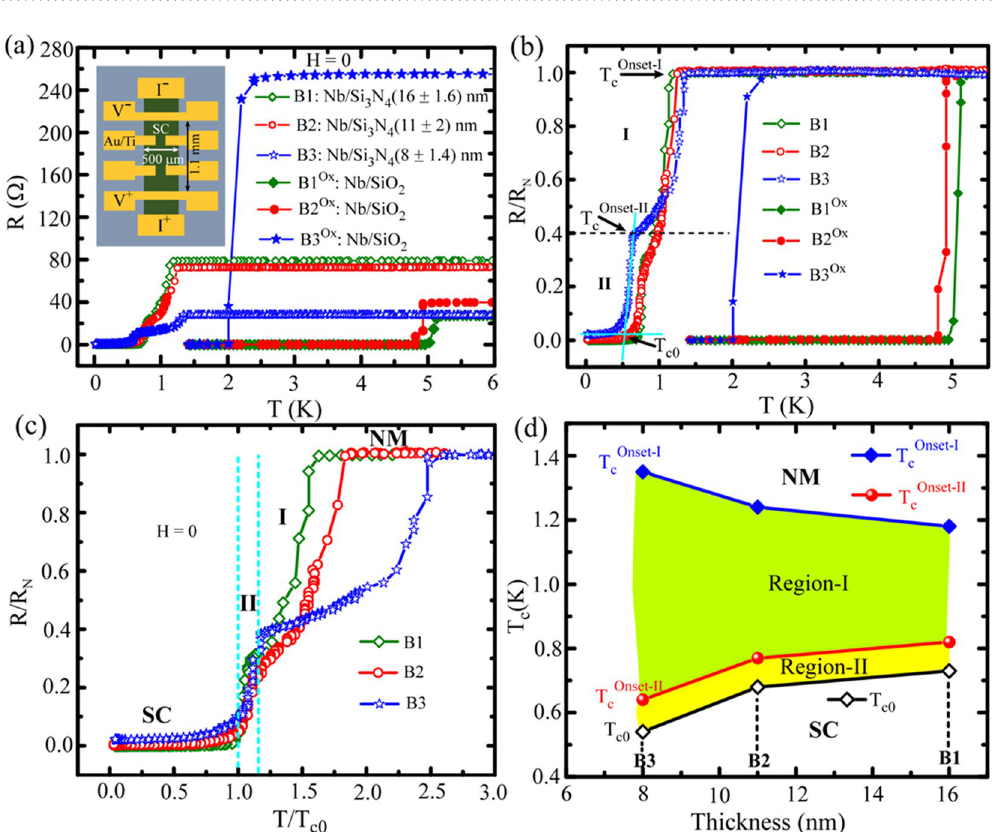
Figure 3. Temperature dependent resistance [ R(T) ] measured at zero-field. ( a ) A set of for three nitride samples with varying thickness and three related to Nb control samples. For each thickness, one nitride sample and one control sample from the same batch have been selected. Inset: device geometry. ( b ) The same set of R(T) is shown with the resistance values normalized by the normal state resistance ( R N ) of individual sample. ( c ) Normalized resistance for the nitride samples are presented in reduced temperature ( T/T c0 ) scale. The vertical dotted lines represent the two transition regimes region-I and region-II. ( d ) Variation of different transition temperature ( T c ) values, defined in ( b ), with thickness for the nitride samples. The shaded regions indicate the dependence of transition width for the two transition regions on the sample